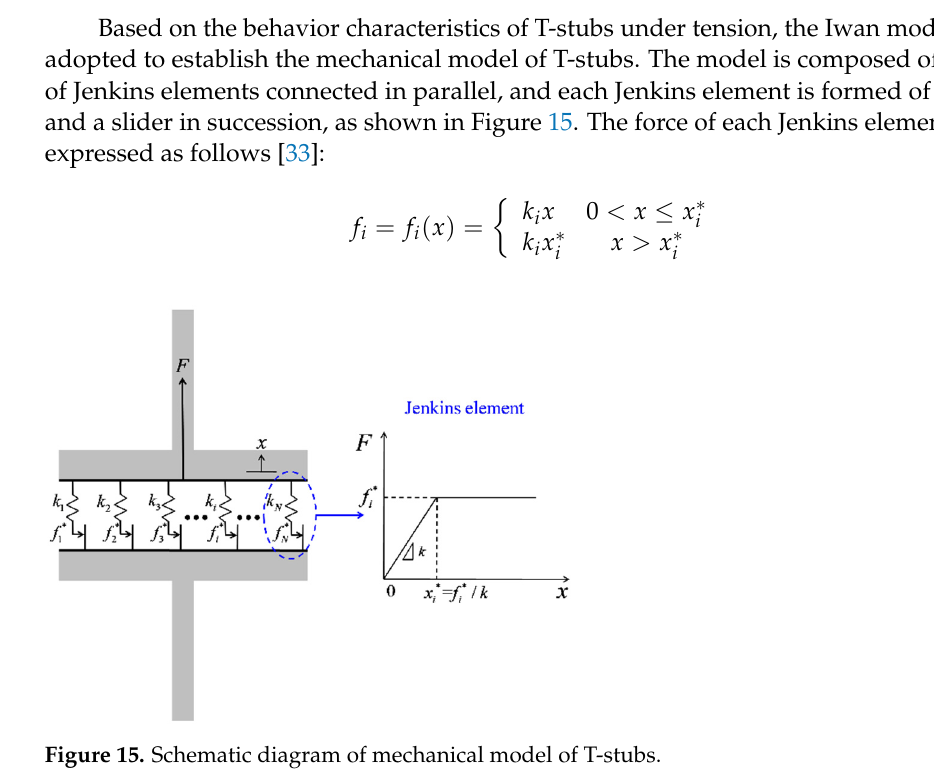
Figure 15. Schematic diagram of mechanical model of T-stubs.